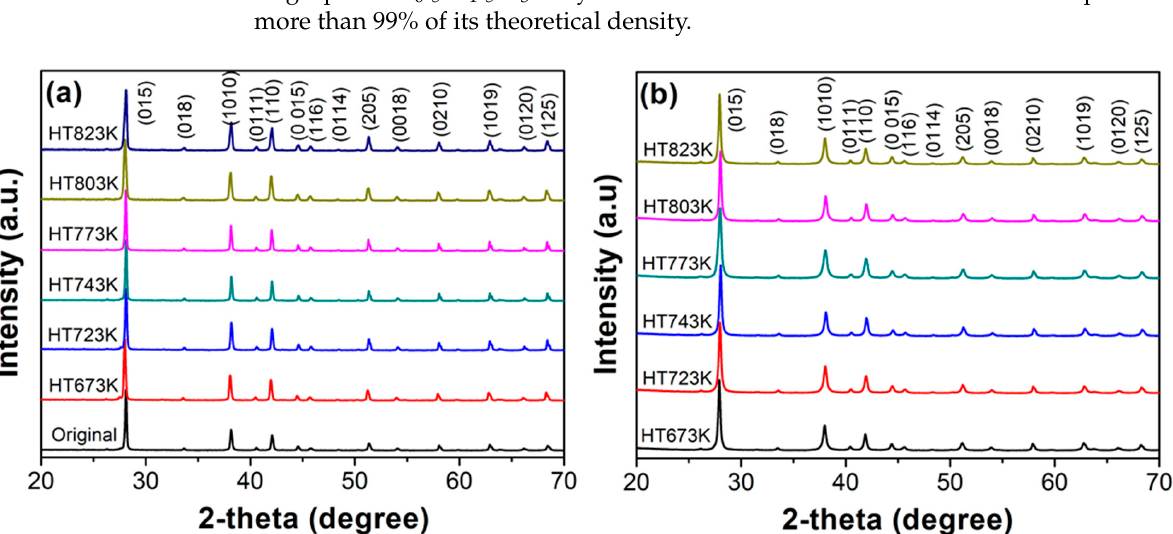
Figure 2. X-ray diffraction patterns of Bi 0 . 5 Sb 1 . 5 Te 3 ( a ) powder, and ( b ) bulk samples obtained using heat treated powder at different temperatures.